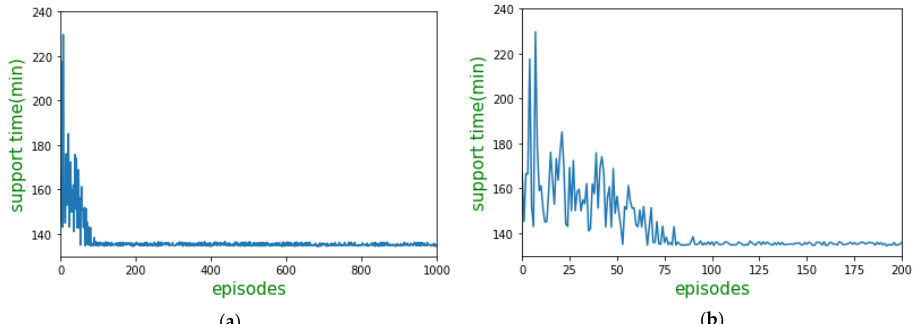
Figure 6. The curve of support time of carrier aircrafts with episodes. ( a ) Description of the curve of maximal support time during one thousand episodes; ( b ) Illustration of how the maximal support time goes with the episode in detail in the former 200 episodes.